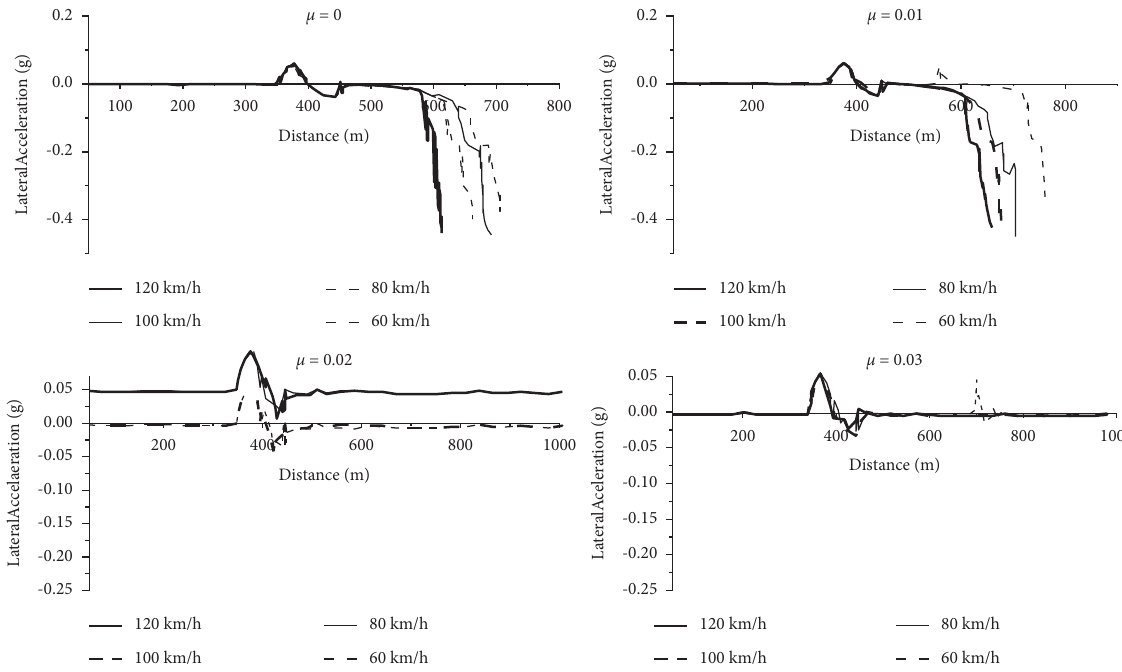
Figure 10: Lateral acceleration at different rutting lengths and speeds ( g